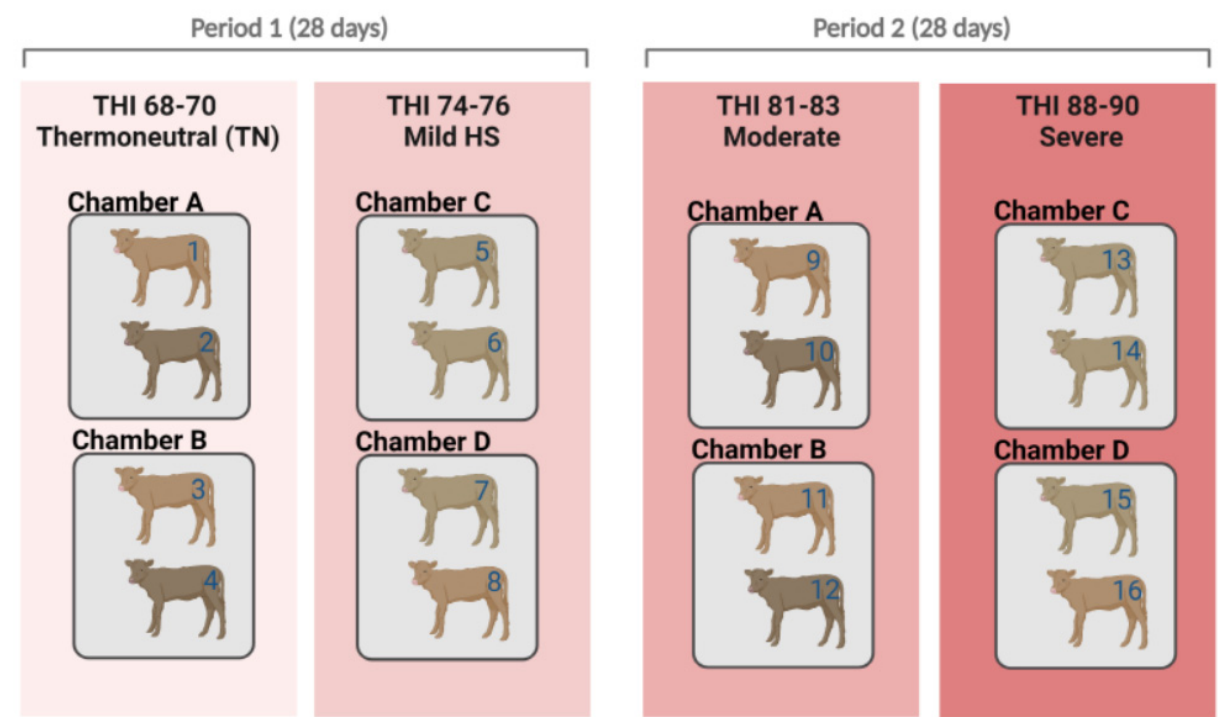
Figure 4. Schematic representation of climate chamber experiments according to heat stress (HS) treatments (thermoneutral, mild, moderate, and severe). Sixteen Hanwoo calves were randomly divided into four homogenized groups. The animals were subjected to ambient temperatures (22 °C) for 7 days in the adaption period one week before the experiment began. Following the adaptation periods, animals were kept in the treatment chambers for 21 days. After the completion of two treatments (thermoneutral and mild HS), we conducted the other two treatments (moderate and severe HS), using the same approach with different calves. THI = temperature–humidity index.